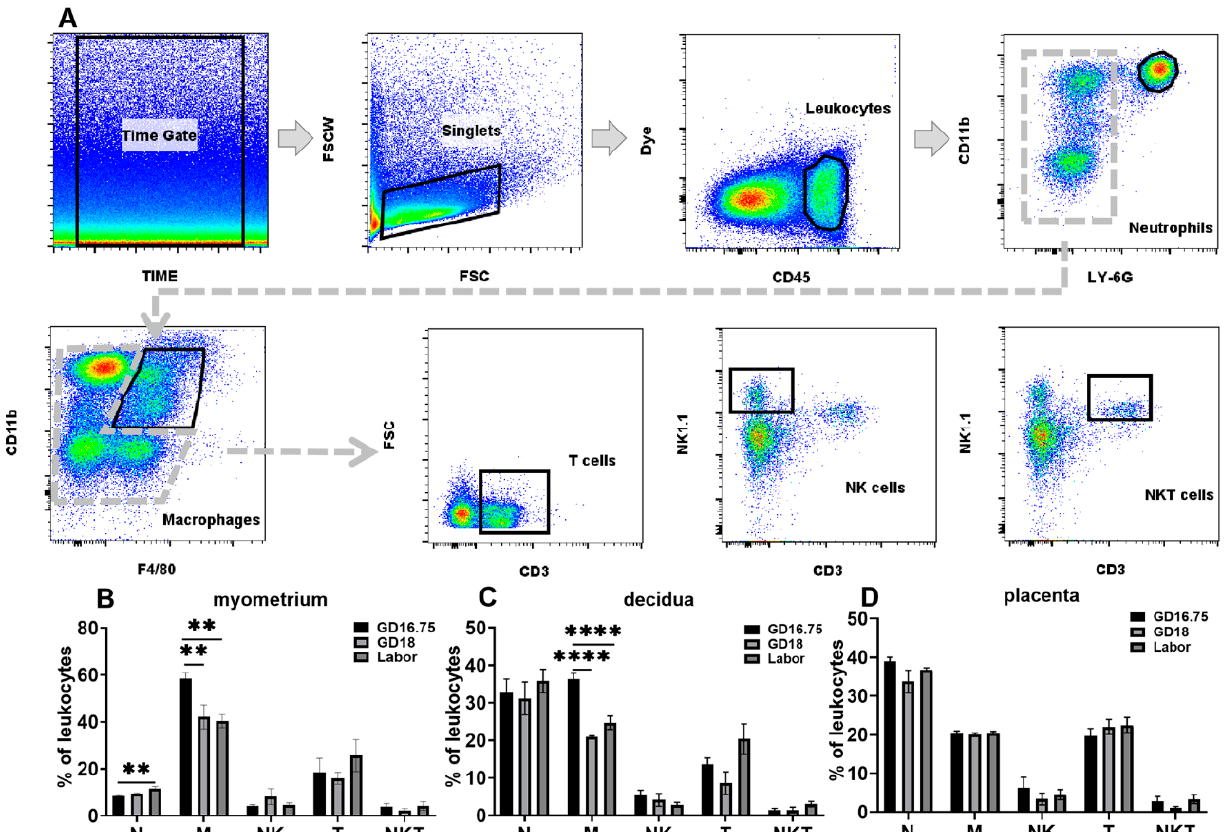
Figure 1. Dynamic changes of leukocyte subsets in myometrium, decidua, and placenta at late gestation and labor. The pregnant mice were sacrificed at GD16.75, GD18, and labor. Myometrium, decidua, and placenta were obtained for examination of the populations of neutrophils, macrophages, NK, T cells, and NKT cells by flow cytometry analysis. ( A ) Gating strategy used to identify neutrophils (Dye − CD45 + CD11b + Ly6G + ), macrophages (Dye − CD45 + CD11b + F4/80 + ), T cells (Dye − CD45 + CD11b − CD3 + ), NK cells (Dye − CD45 + CD11b − CD3 − NK1.1 + ), and NKT cells (Dye − CD45 + CD11b − CD3 + NK1.1 + ). ( B ) Populations of leukocyte subsets in myometrium; ( C ) populations of leukocyte subsets in decidua; ( D ) populations of leukocyte subsets in placenta. Data are expressed as mean ± SEM. n = 6 in each group. ** p < 0.01, **** p < 0.0001. N, neutrophils; M,